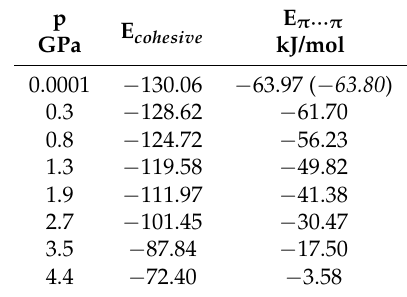
Table 3. Variation of the cohesive energy and the energy of the π · · · π stacking interaction of all intermolecular interaction in the crystal structure of 1a as estimated with CRYSTAL14 [35] in kJ/mol. The intermolecular interaction energies from periodic DFT and CrystalExplorer [28] estimation (in brackets) were remarkably close at ambient